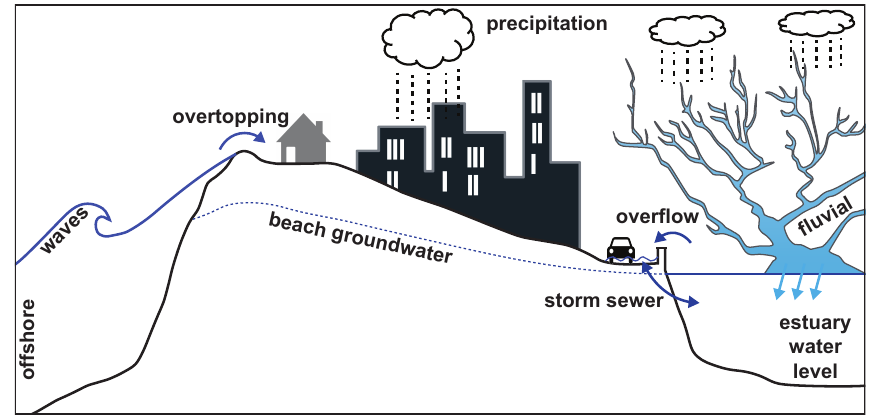
Figure 1. Cross-shore transect showing the region of interest from the nearshore to the